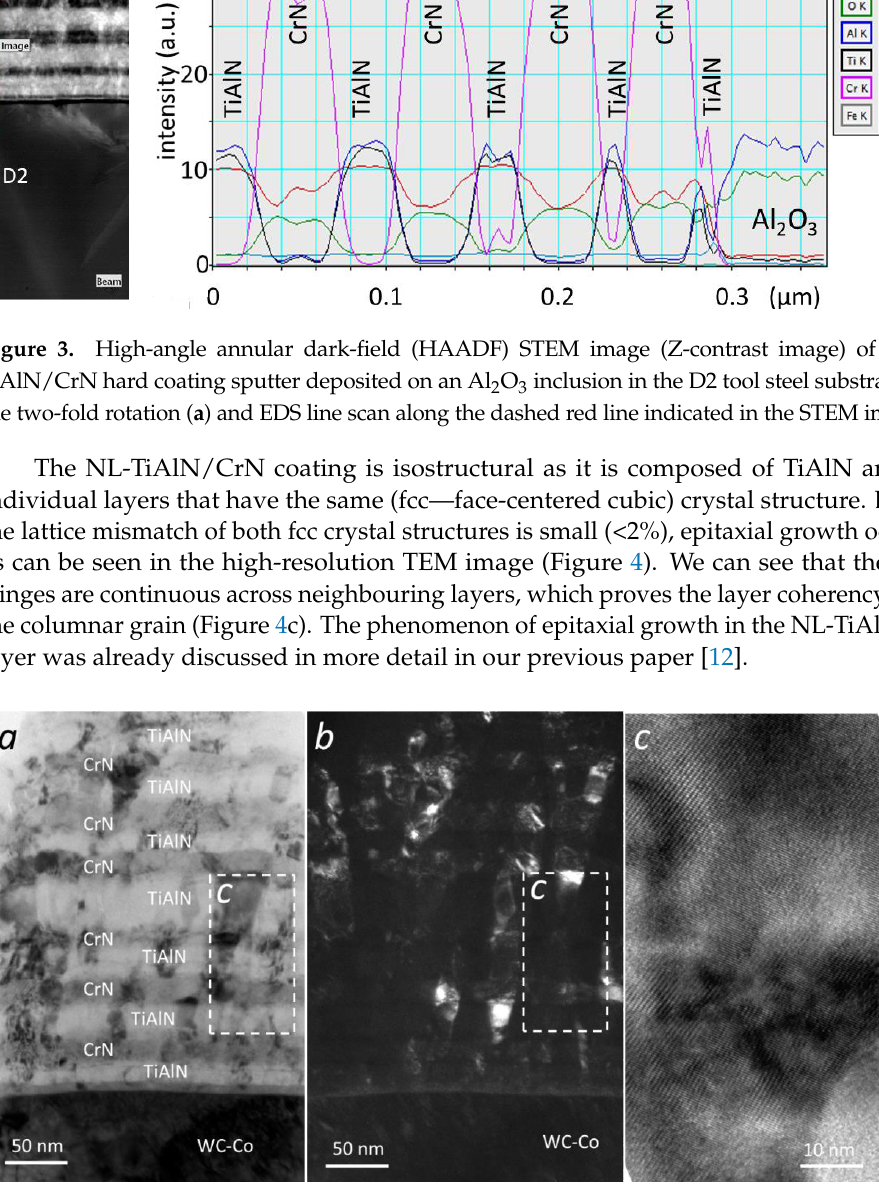
Figure 4. Bright- ( a ) and dark- ( b ) field TEM images of the same area of the NL-TiAlN/CrN hard coating deposited on cemented carbide substrate using the three-fold rotation; ( c ) high resolution TEM image of the area inside of the frame; the lattice fringes clearly show coherency between the